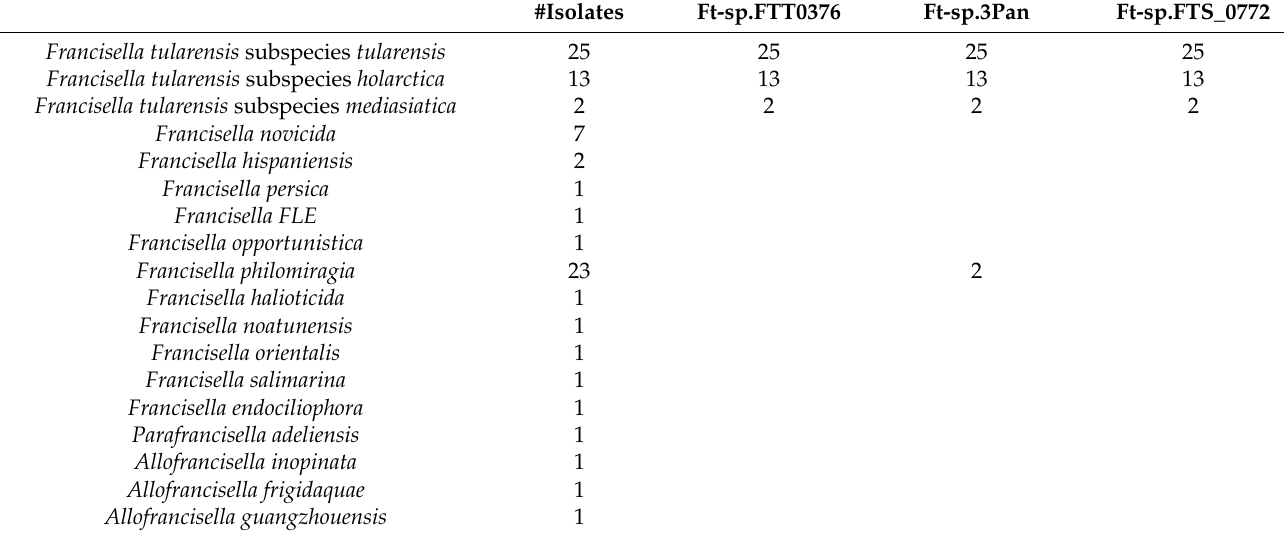
Table 5. Assay performance for isolates included in the validation panel. Number of isolates indicates the number of strains per species/subspecies included in the validation panel. Numbers in the other columns indicate the number of positive results (i.e., purported F. tularensis -positive results) for each of the three examined PCR